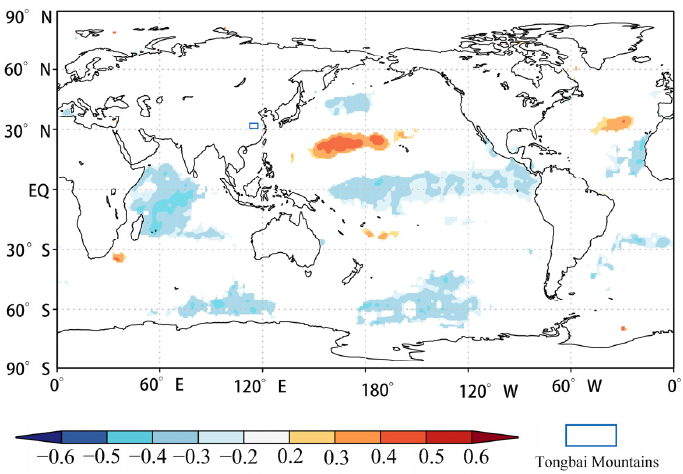
Figure 12. The spatial teleconnection between the reconstructed T MJ series and the HadISST1 1° sea surface temperature during the common period of 1901–2005.